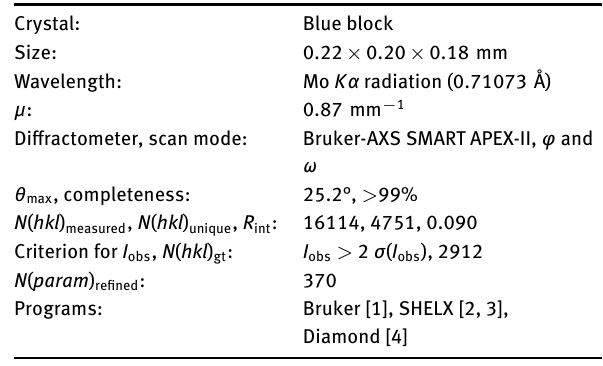
Table 1: Data collection and handling.